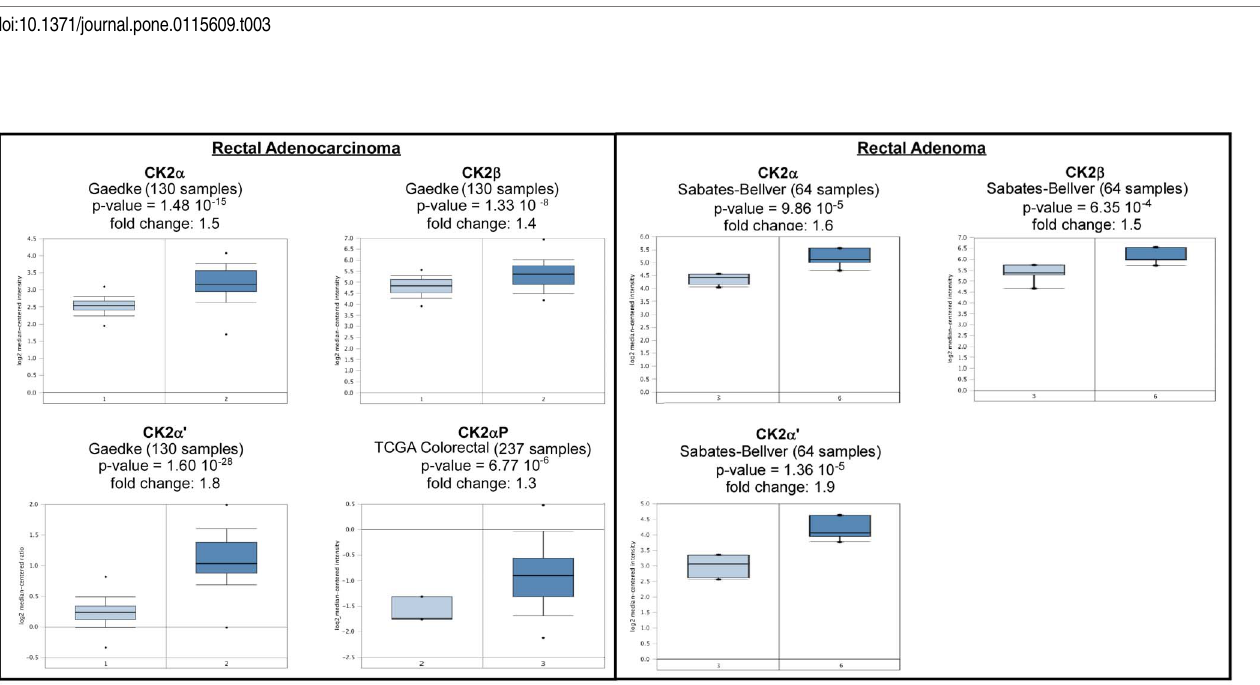
Different subtypes of colon cancer are analyzed and p-values, fold changes, and datasets are included.